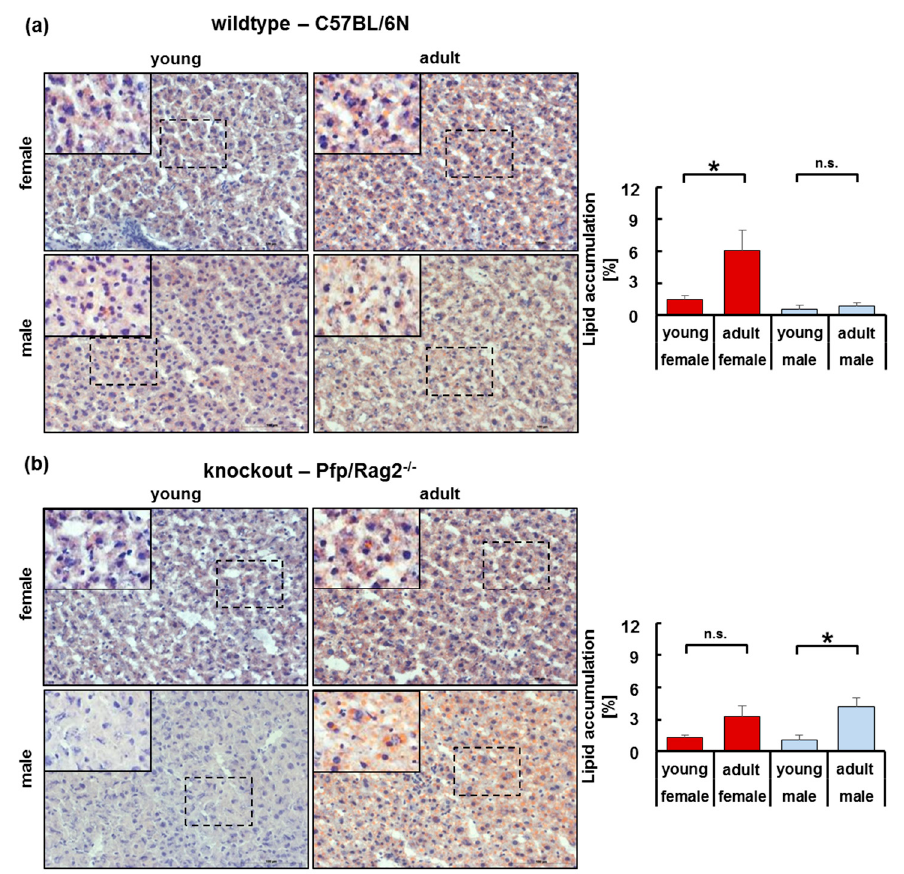
Figure 3. Lipid content in livers from wildtype ( a ) and knockout ( b ) female and male mice. Liver lipids were stained with Sudan III (orange staining, left panels) and quantified by image analysis (right panels, female in bold (red) and male (blue) in light shades). Horizontal lines marked with an asterisk indicate significant differences at the p ≤ 0.05 level; n.s. indicates no significant differences. Insets (bold lines) in the histological images show higher magnifications of the areas indicated by dashed lines.